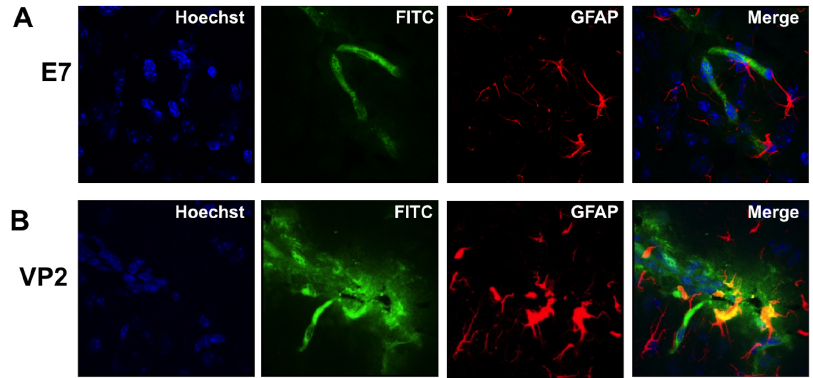
Figure 3. Increased astrocyte activation colocalizes with CNS vascular permeability post-induction of PIFS in perforin 2 / 2 mice reconstituted with perforin competent CD8 T cells. Representative confocal microscopic images illustrating astrocyte expression of GFAP in (A) E7 peptide-treated (n=4) and (B) VP2 121–130 peptide-treated (n=6) perforin 2 / 2 mice reconstituted with perforin competent CD8 T cells. Mice treated with (B) VP2 121–130 peptide displayed increased astrocyte activation, as measured by heightened GFAP expression, in areas of CNS vascular permeability when compared to (A) mock E7 peptide-treated negative control mice. CNS permeability is determined by leakage of intravenously administered FITC-albumin.